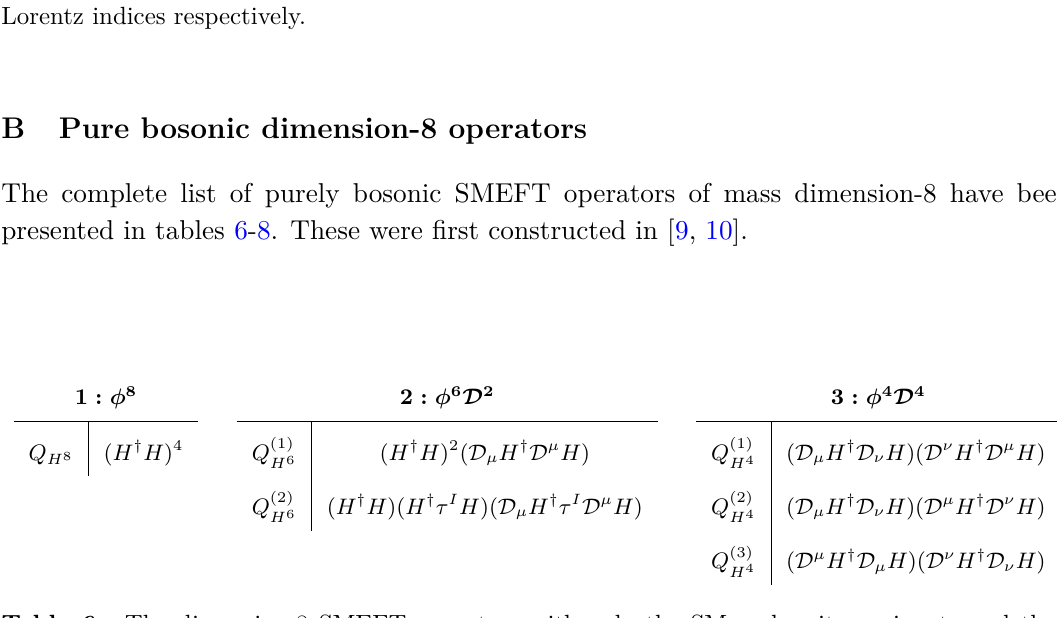
Table 5. Standard Model: gauge and global quantum numbers and spins of the fields. Here, A = 1 , 2 , · · · , 8 ; I = 1 , 2 , 3; p = 1 , 2 , 3 and µ = 0 , 1 , 2 , 3 refer to the SU(3) , SU(2) , flavour and Lorentz indices respectively.